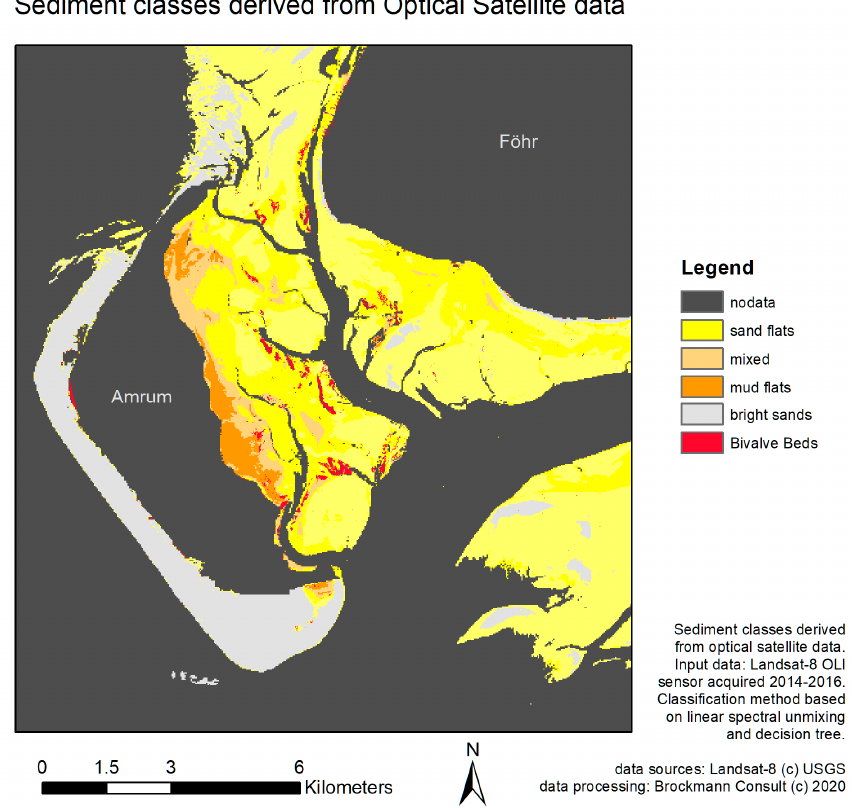
Figure 2 . Classification of surface sediments and bivalve beds in the study area on the German North Sea coast, based on optical/IR data (Landsat-8 OLI acquired 2014–2016; © Brockmann Consult 2020). Islands and open water are masked out (“no data”).